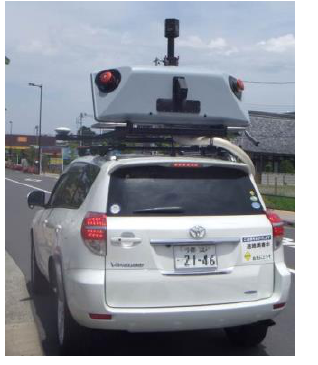
Figure 5. MMS with MX-8